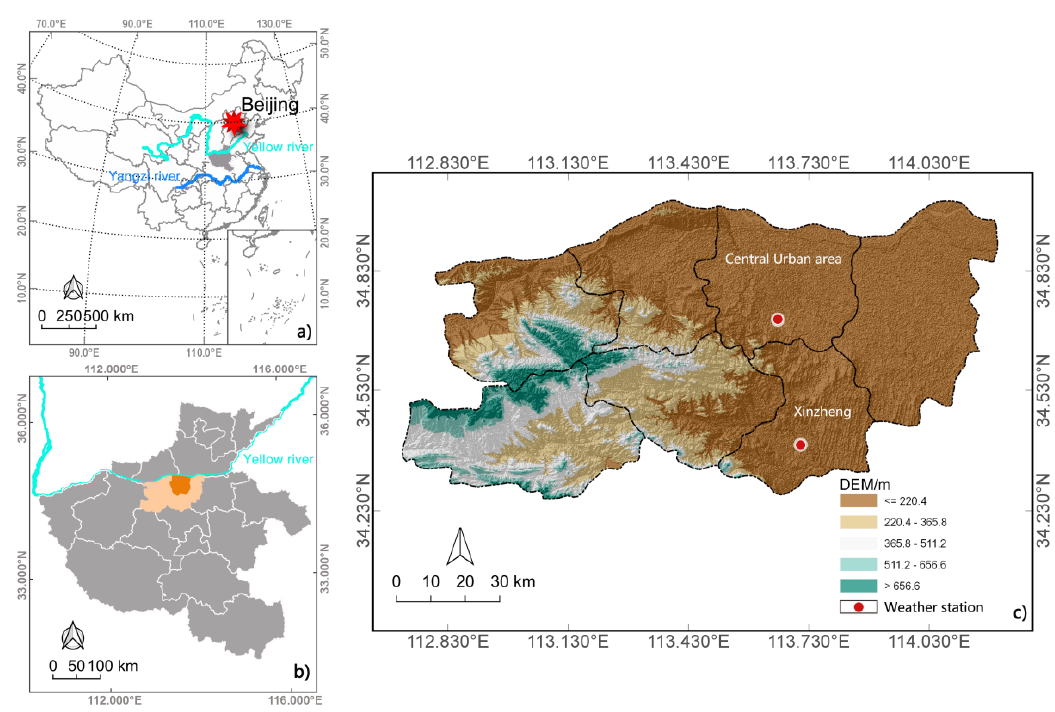
Figure 1. Location of the study area: ( a ) Henan province in China, ( b ) Zhengzhou in Henan province, and ( c ) Zhengzhou DEM map and weather stations.